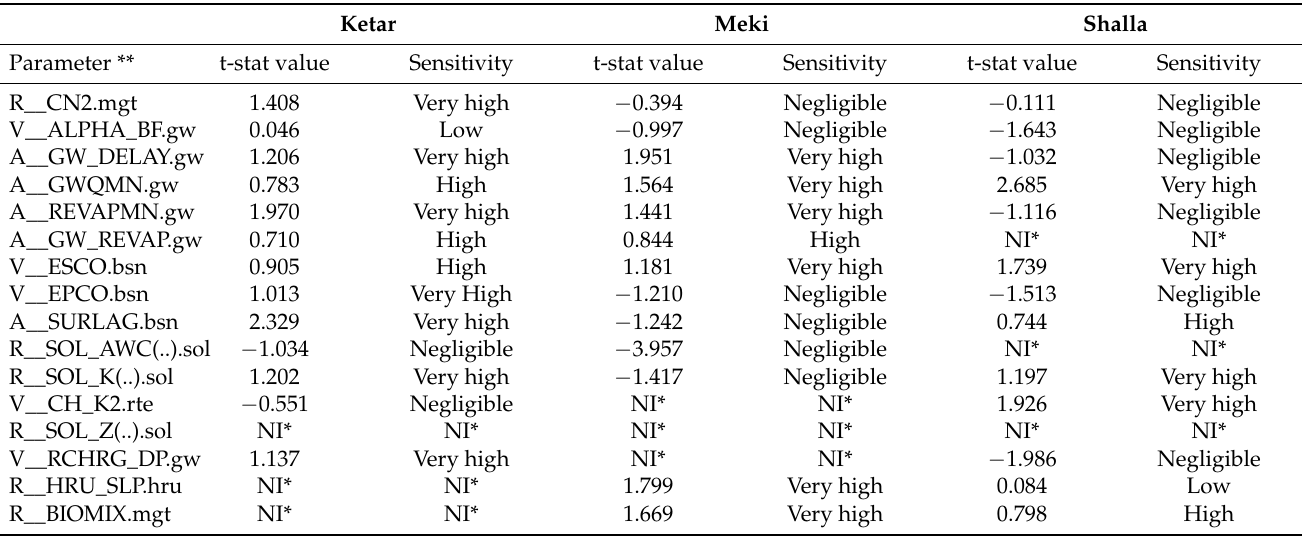
Table 6. Sensitivity or mean of index I values of the selected parameters for the sub-basins, according to their “t-stat” results as per the scale indicated in Table 2.